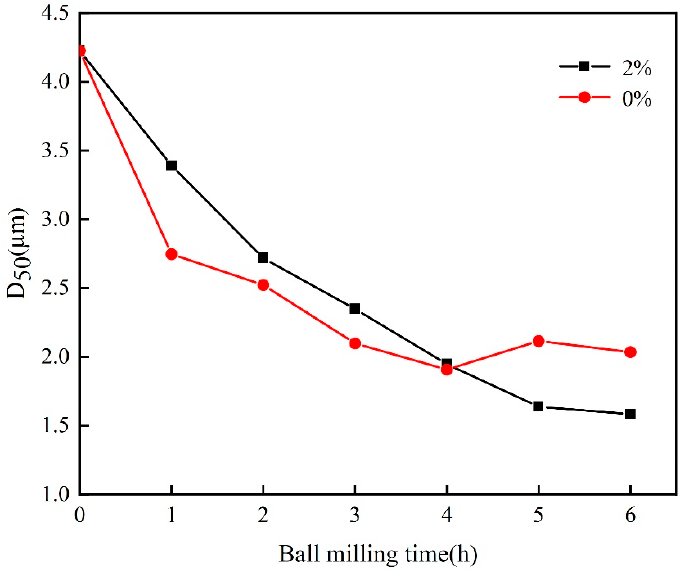
Figure 1. The change of D 50 of kaolin at di ff erent milling times when adding a modi fi er. When the content of the modi fi er is 2%, with the increase in ball milling time, the